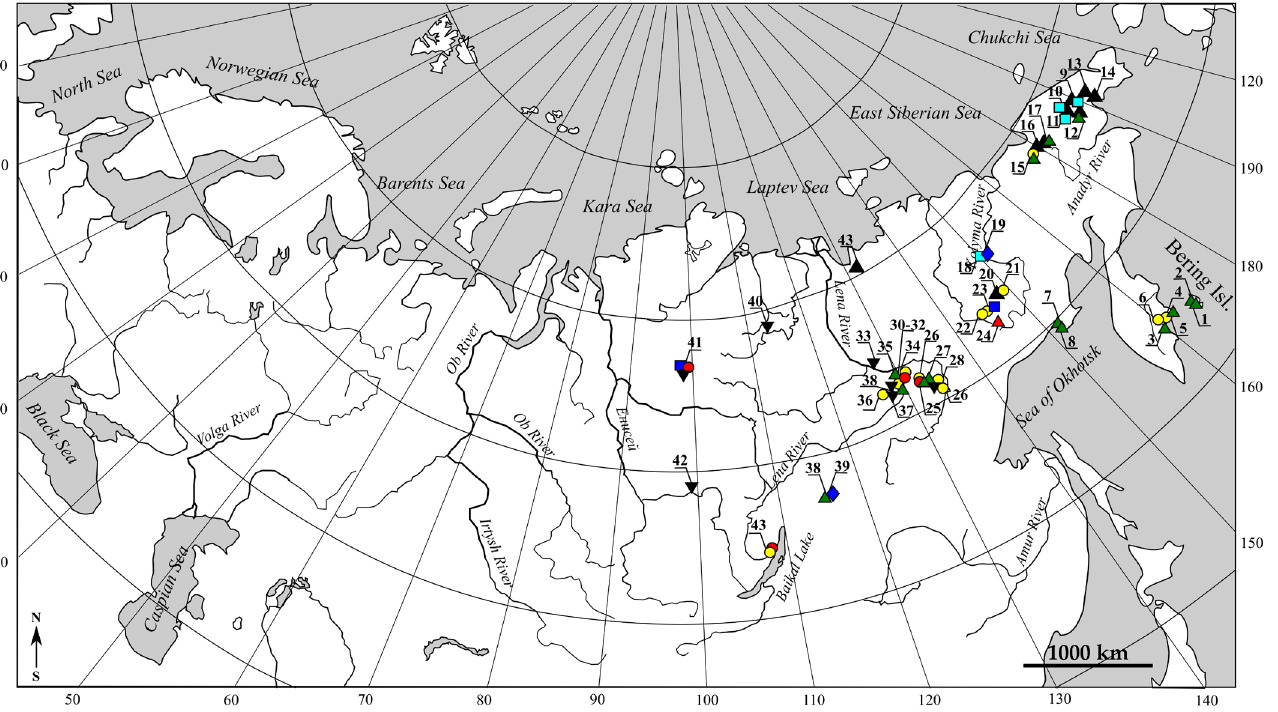
Figure 1. Map of the Daphnia sampling localities and species distribution in the water bodies of Russian part of the arctic–subarctic zone; red circle— D. longispina s.str., yellow circle— D. dentifera , upside black triangle— D. galeata , red triangle— D. umbra , blue square— D. cristata , turquois square— D. longiremis , blue diamond— D. curvirostris , black triangle— D. middendorffiana , green triangle— D. pulex . Numbers of sampling sites correspond to Table S1.